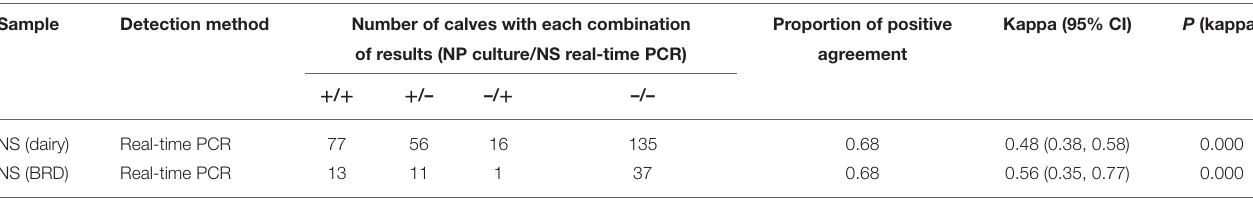
TABLE 2 | Agreement between deep nasopharyngeal swab (NP) culture and nasal swab (NS) PCR in detecting M. bovis in dairy herd calves ( n = 284) and calves with respiratory disease (BRD, n = 62).